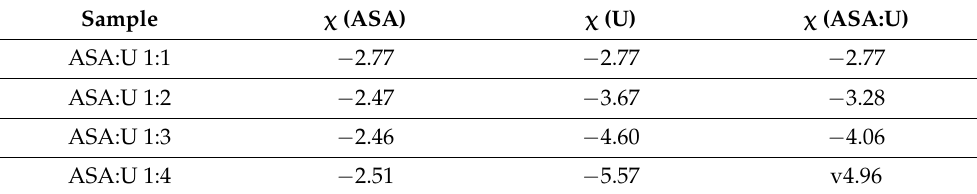
Table 5. Effective interaction parameters of the ammonium sulfamate–urea system.